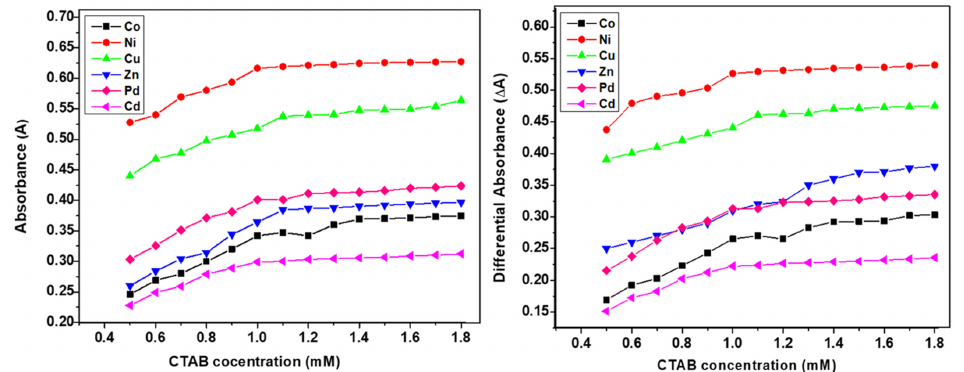
Figure 4. Plots of simple and differential absorbance vs. Cetyltrimethylammonium bromide (CTAB) concentration . Table 2. Partitioning and binding parameters of M(II) complexes in micellar media .